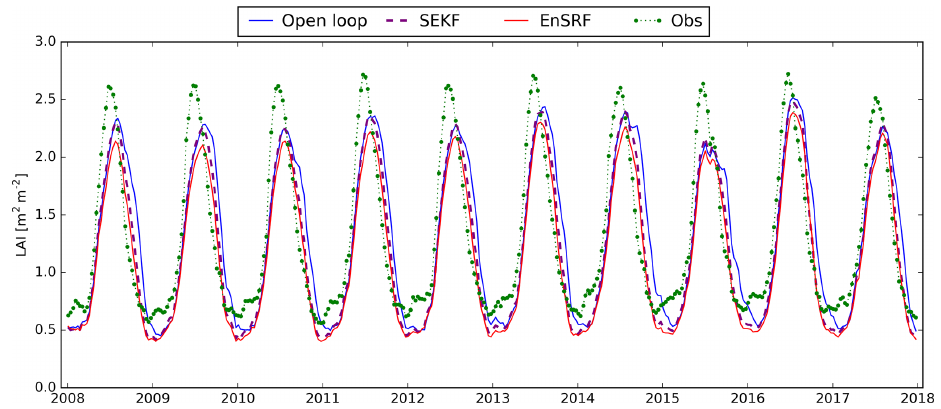
Figure 2. 10d time series of LAI averaged over the whole domain from the open loop (blue line), observations (green dots and dotted line) and analyses obtained with the SEKF (dashed purple line) and the EnSRF (red line) for the period 2008–2017. Table 1. Statistics (RMSD: root mean square difference, nRMSD: normalized RMSD, R : correlation and bias) between LDAS-Monde estimates (open loop, SEKF and EnSRF) and observations for CGLS SSM, CGLS LAI, GLEAM ET and FLUXCOM GPP averaged over the Euro-Mediterranean region for the period 2008–2017 (for SSM, LAI and ET) or 2008–2013 (for